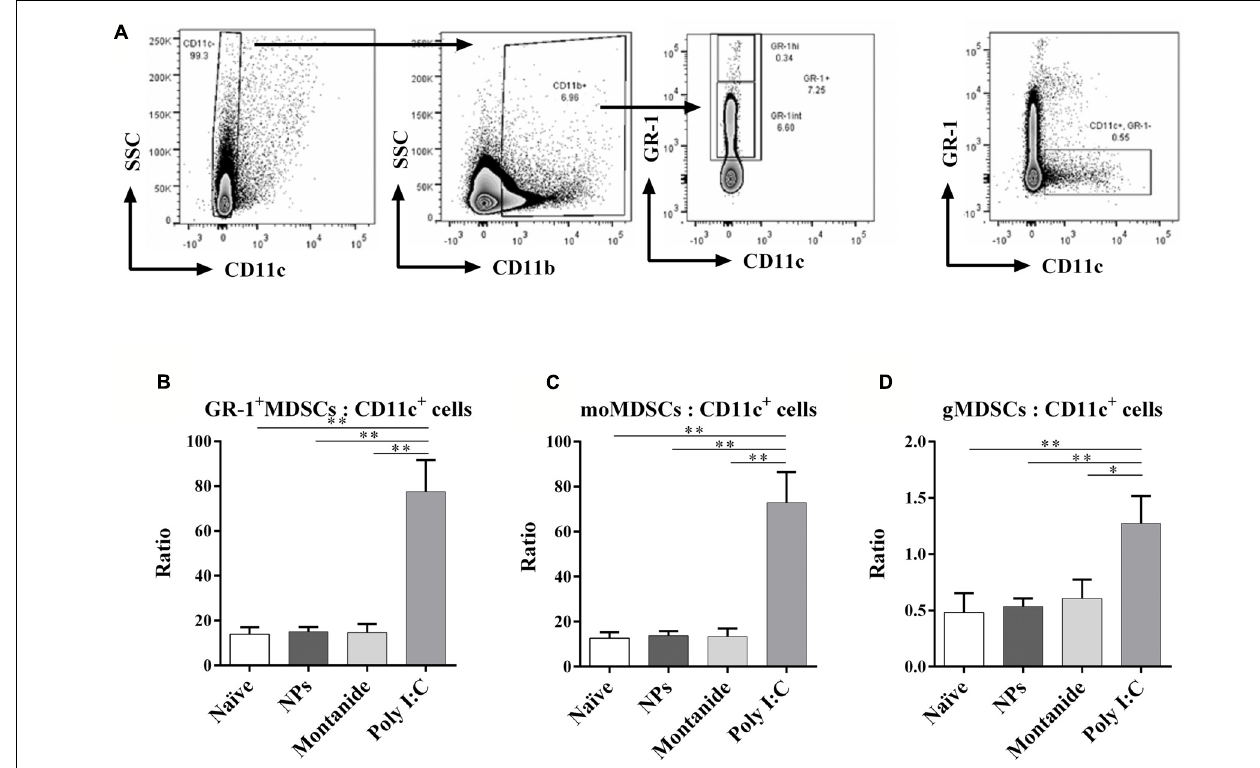
FIGURE 5 | Differential expression of GR-1 + MDSCs and DCs in the local dLN. Mice (BALB/c) were injected once intradermally at the base of the tail with the different adjuvants alone. 48 h after injection, mice were sacrificed, local (inguinal) dLNs were harvested and levels of GR-1 + MDSCs and DCs, and their ratios, were assessed by flow cytometry.